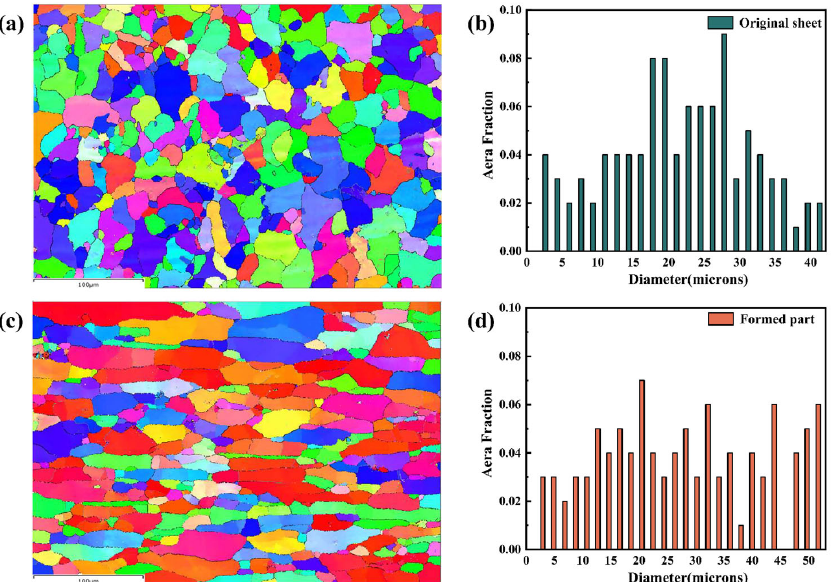
Figure 10. ( a ) EBSD diagram of the original 5083Al sheet; ( b ) Grain size statistics of the original 5083Al sheet, ( c ) EBSD diagram of 5083Al after blow forming; ( d ) Grain size statistics after blow